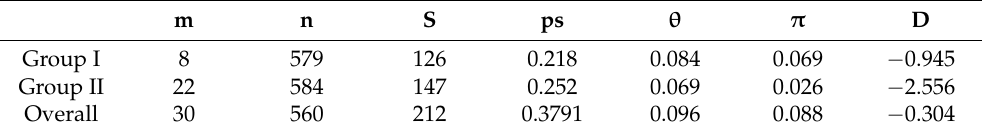
Table 3. Tajima’s test statistics for the 5.8S rRNAplus ITS sequences of Orobanche . m n S ps θ